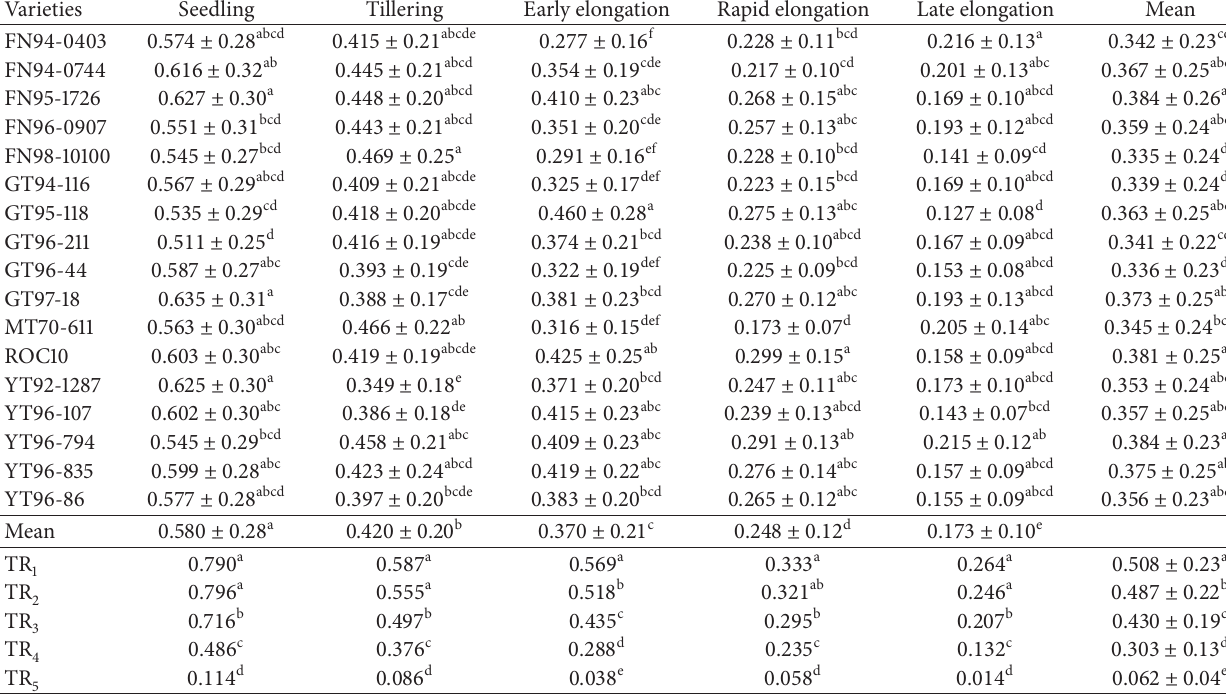
Table 4: Seasonal changes of transmission coefficient for solar beam radiation penetration in sugarcane varieties.